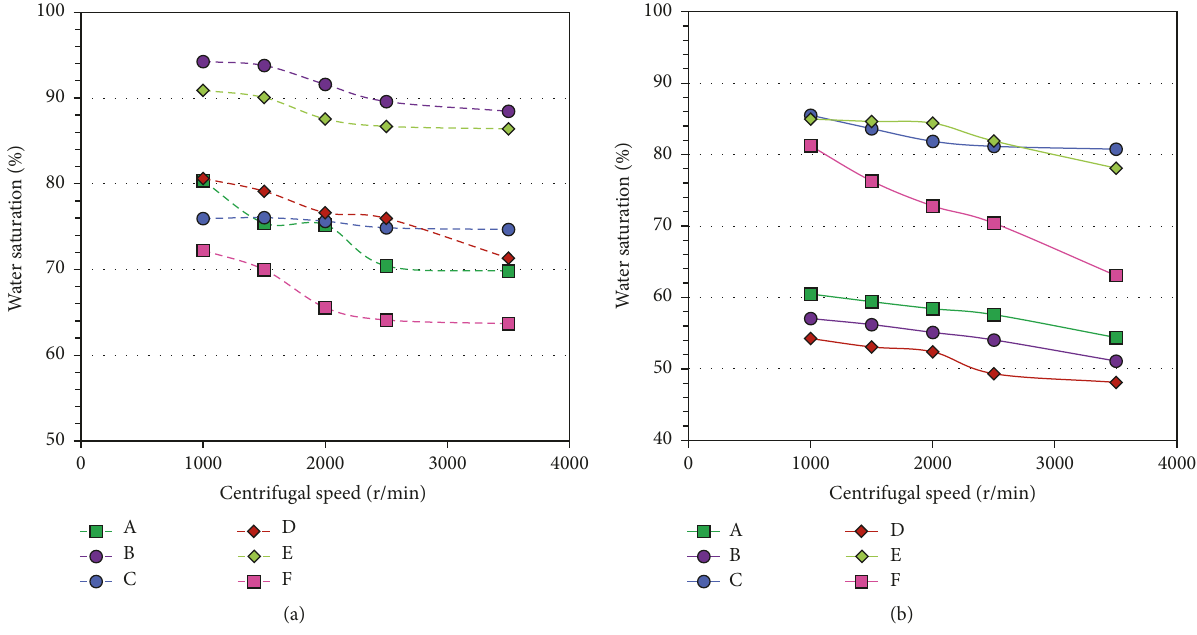
Figure 3: Centrifuge experiments for various volcanic samples: (a) distilled water and (b) anion water.